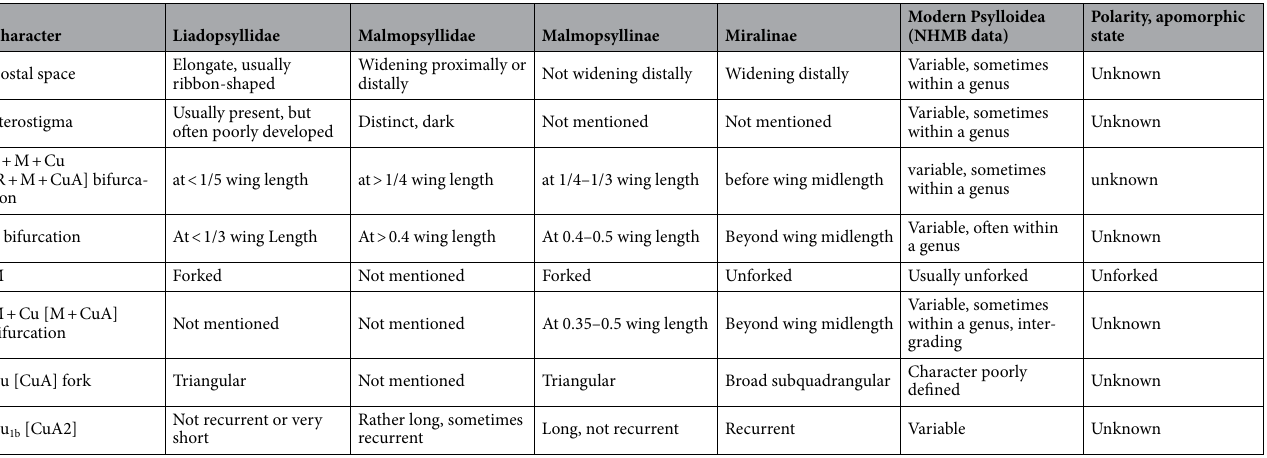
Table 2. Forewing characters used by Shcherbakov 9 to define the families and subfamilies. Nomenclature of veins follows Burckhardt & Poinar 4 , terms used by Shcherbakov 9 are given in